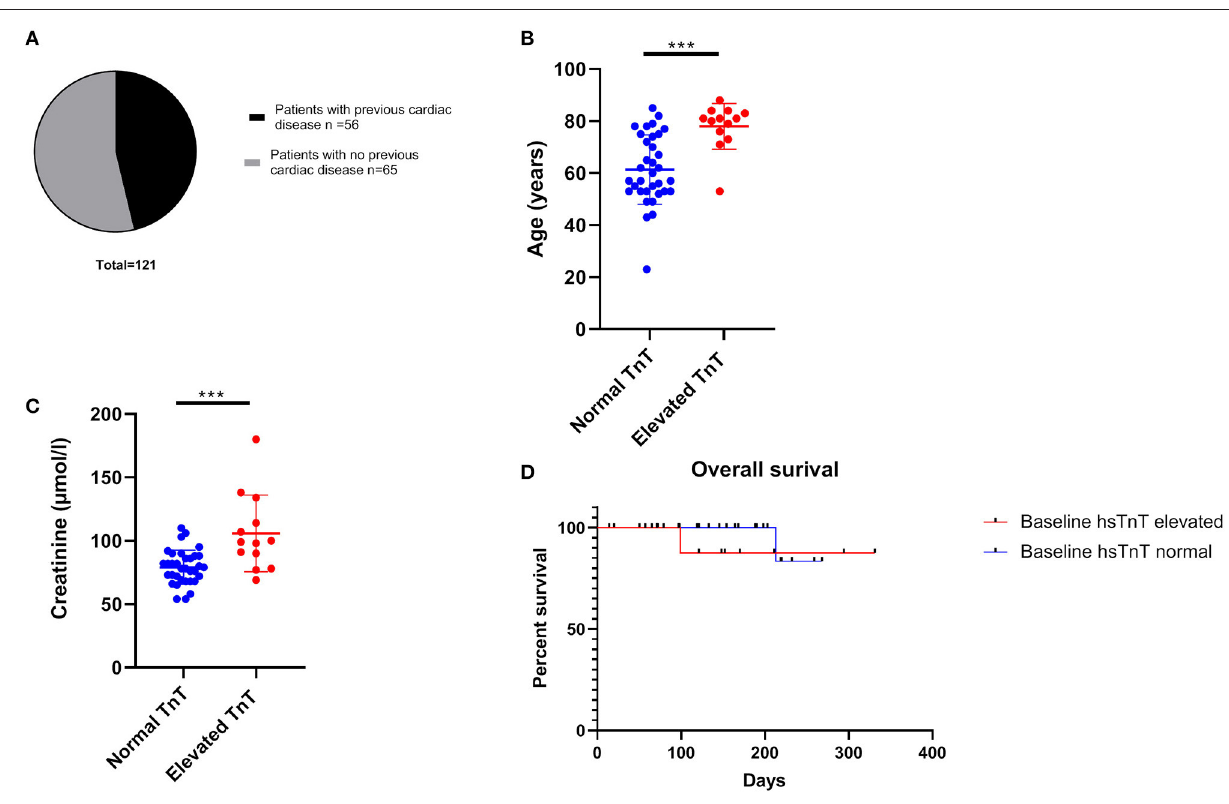
FIGURE 3 | Cardiac co-morbidity status and factors associated with elevated hsTnT concentrations. (A) Almost 50% of all patients had pre-existing ischaemic heart disease. Age ( B ) and elevated baseline creatinine concentration (C) were significantly associated with increased hsTnT levels *** p < 0.001. (D) overall survival was not significantly different between the elevated and normal hsTnT